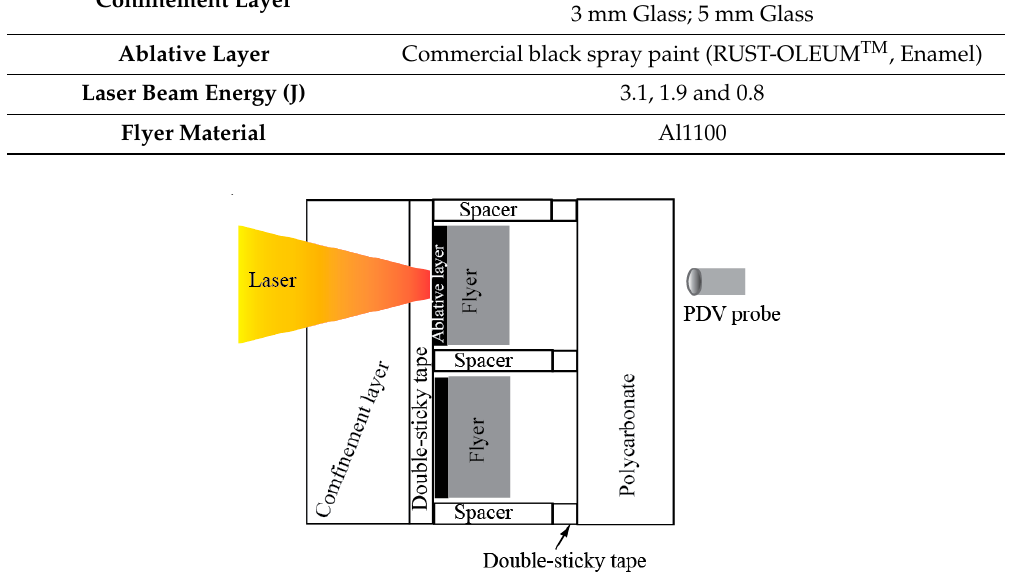
Figure 1. Schematic experimental setup of the flyer velocity measurement for laser impact welding (LIW).